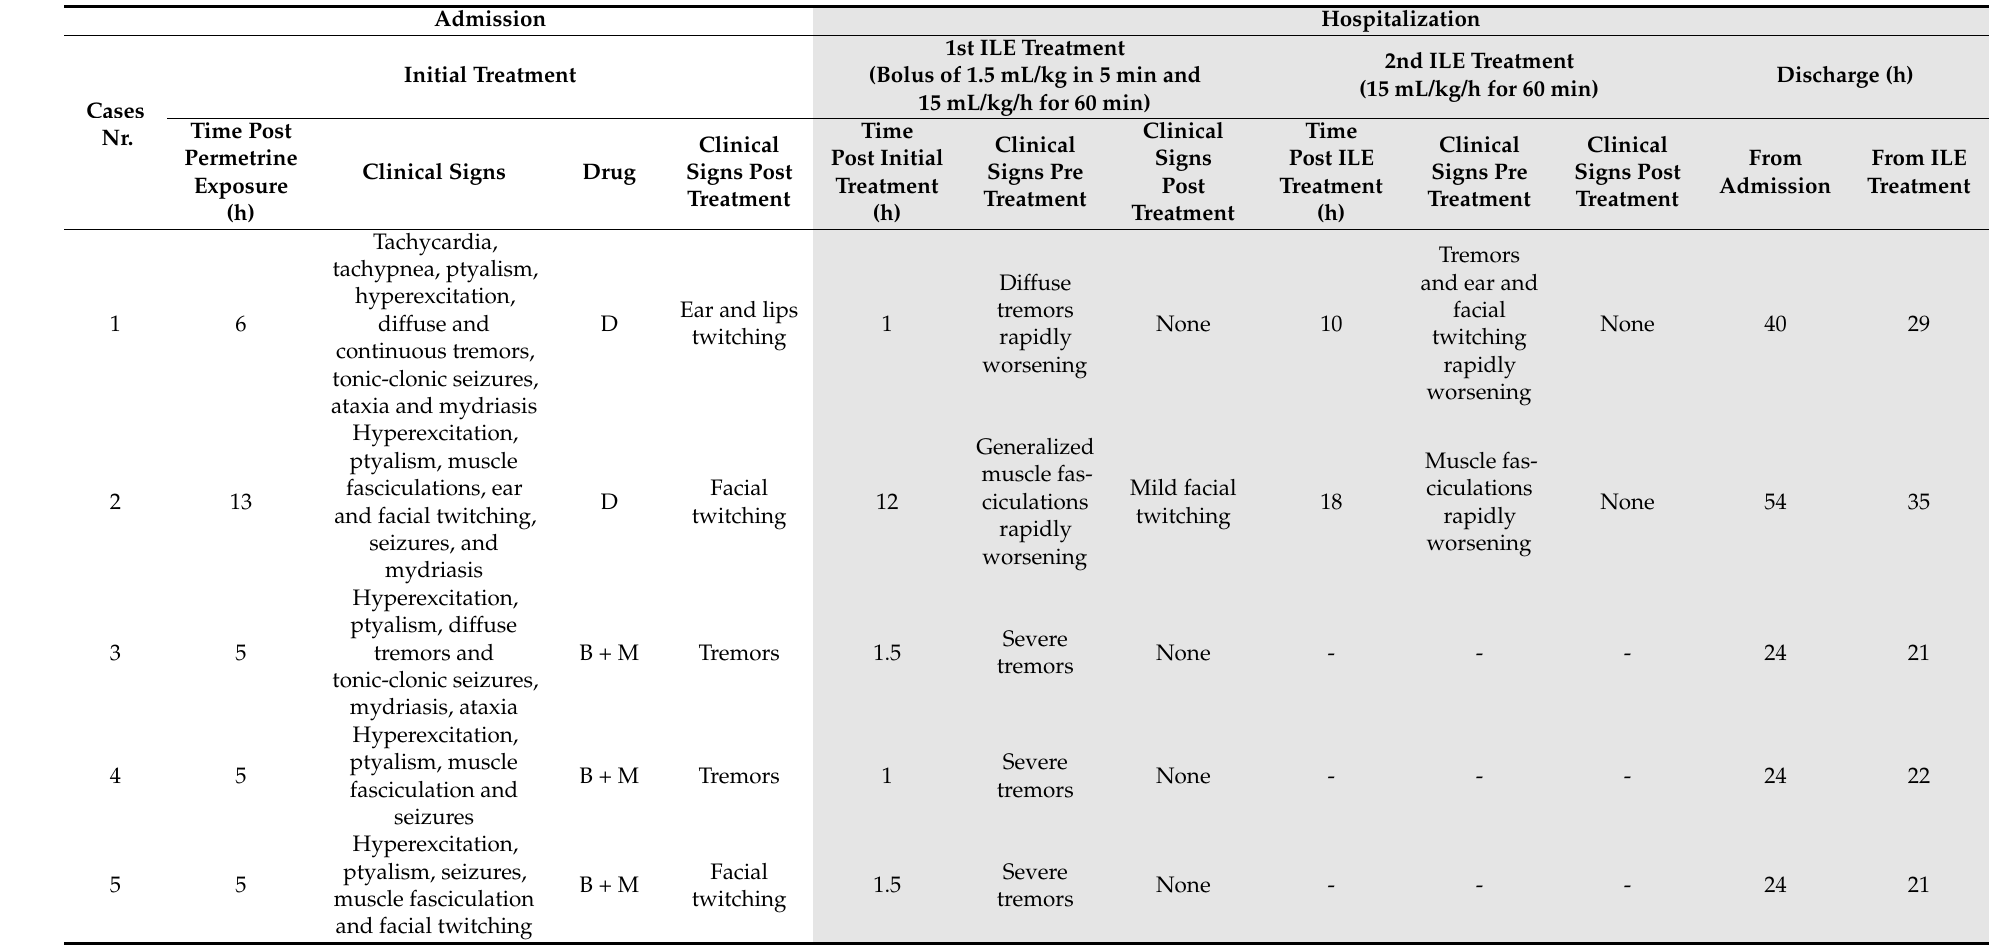
Table 2. Clinical signs of cats at admission and during the hospitalization, and treatments